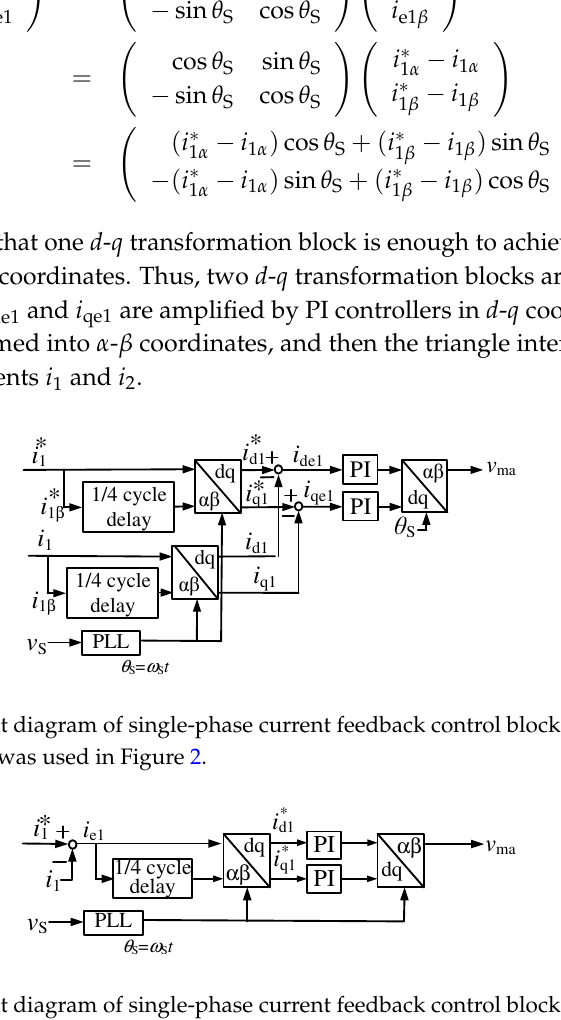
Figure 6. Control circuit diagram of single-phase current feedback control block in d - q coordinates in d - q coordinates, which was used in Figure